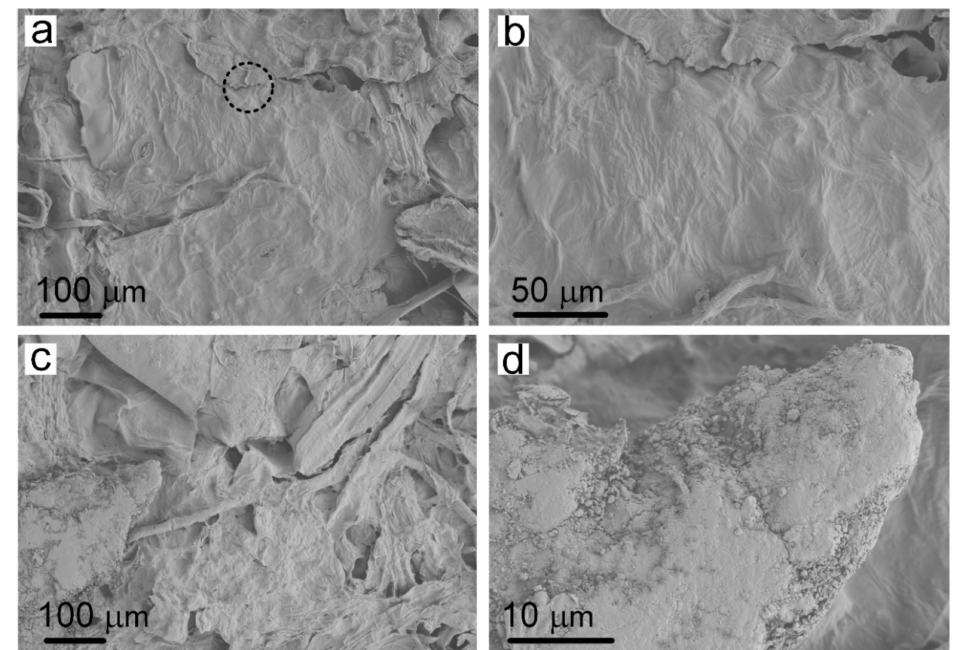
Figure 6. SEM images of: ( a ) the reconstituted tobacco and ( b ) the magnified image of reconstituted tobacco sheet; ( c ) PT-reconstituted tobacco and ( d ) the dried organic tobacco extract adhering to the PT-reconstituted tobacco